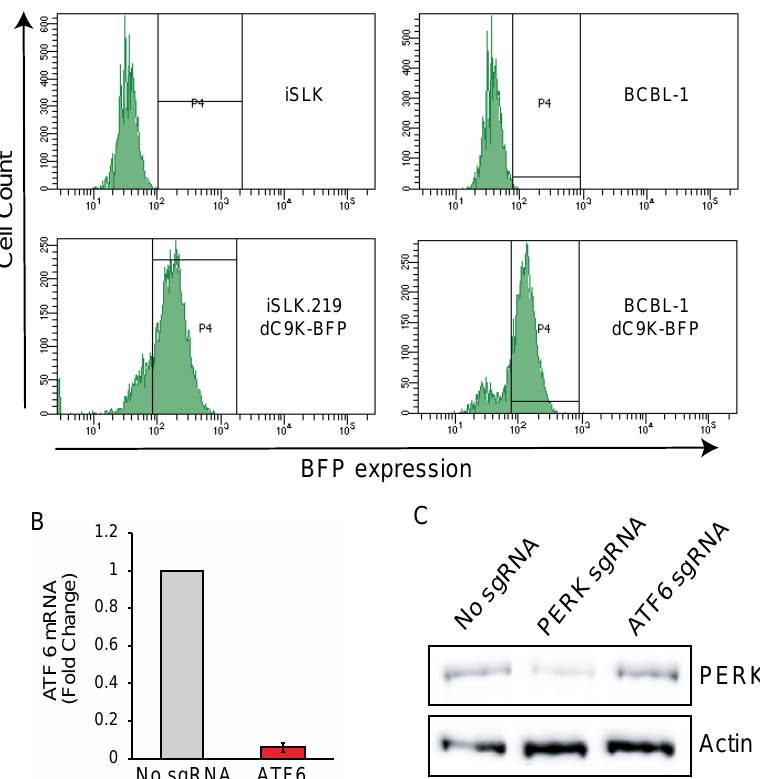
Figure 1. Generation of iSLK-219-dC9K and BCBL-1-dC9K cell lines. ( A ) FACS traces showing mean fluorescence intensity (MFI) of iSLK-219 and BCBL-1 cells transduced with a lentiviral vector expressing dCas9-KRAB-BFP-Blasticidin, selected with blasticidin for 10 days and sorted by FACS for BFP+ expression (P4 gate) ( B ) RT-qPCR showing silencing of ATF6 in BCBL-1 cells. BCBL-1-dC9K cells were transduced with an ATF6 sgRNA targeting vector and selected with puromycin for 10 days. 28S rRNA was used as a loading control. Error bars: standard deviation ( C ) immunoblot showing silencing of PERK 10 days after iSLK-219 cells were transduced with a PERK sgRNA targeting vector and selected by FACS